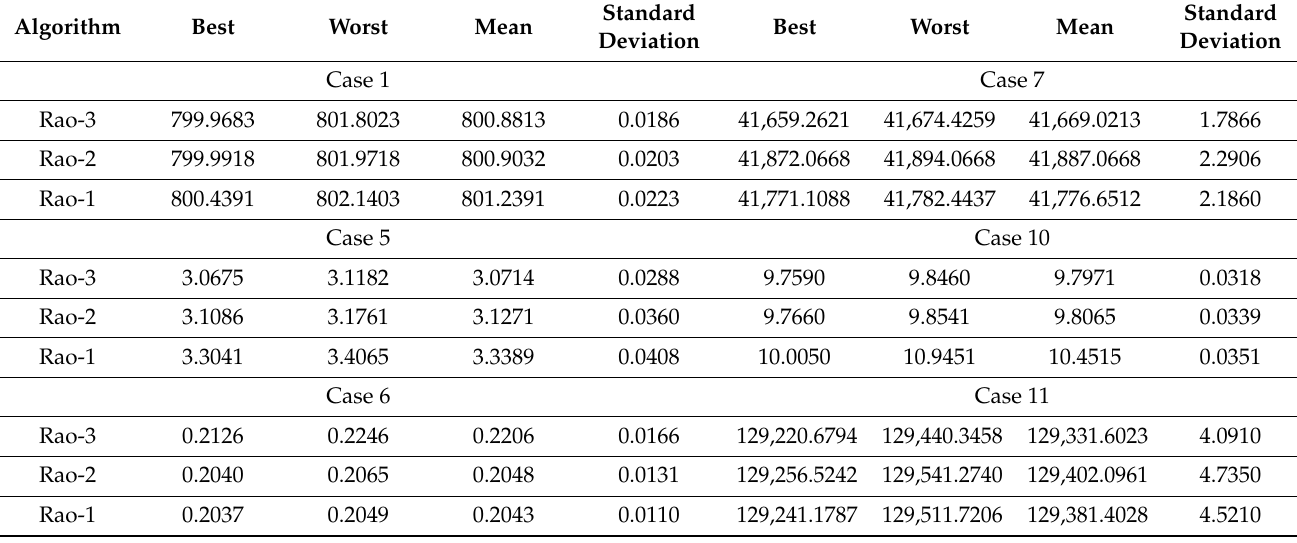
Table 19. Statistical analysis of the various cases using the Rao algorithms.